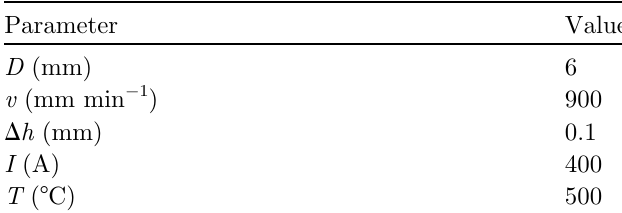
Table 4. Values of forming parameters. Parameter